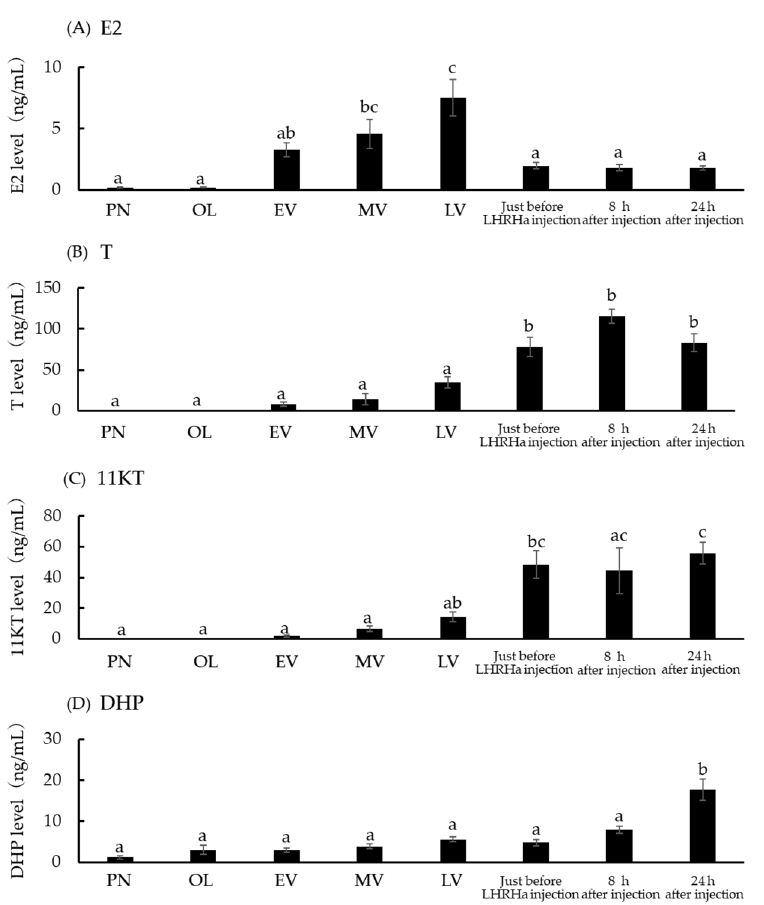
Figure 6. Serum E2, T, 11KT, and DHP levels in individuals at different ovarian developmental stages. Serum steroid levels in individuals whose oocytes were in the perinucleolus stage ( n = 3), oil droplet stage ( n = 4), early-vitellogenic stage ( n = 4), mid-vitellogenic ( n = 4), and late-vitellogenic stage ( n = 6), and in the ovarian follicles collected just before injection ( n = 11), 8 h after the first injection ( n = 5), and 24 h after the first injection ( n = 11). Individuals injected with LHRHa were only those that reached ovulation. ( A ), ( B ), ( C ) and ( D ) indicate the serum E2, T, 11KT and DHP level, respectively. PN, perinucleolus stage; OL, oil droplet stage; EV, early-vitellogenic stage; MV, mid-vitellogenic stage; LV, late-vitellogenic stage. Different letters represent a significant difference among groups ( p < 0.05).